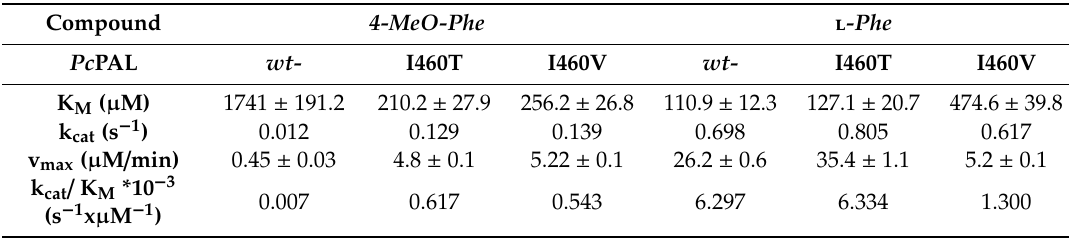
Table 1. Enzyme kinetic parameters for the ammonia eliminations from p -methoxyphenylalanine and natural substrate L -Phe catalyzed by wild-type Pc PAL and variants I460.